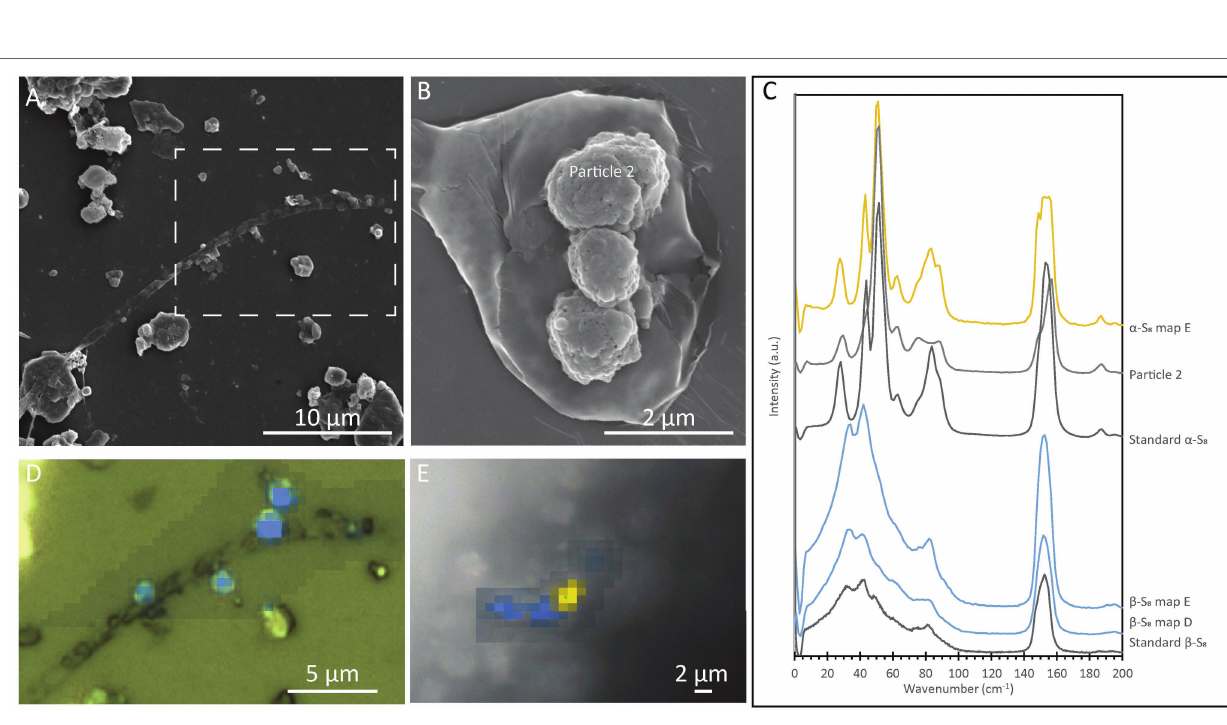
FIGURE 5 | Correlative SEM and Raman analyses of a filamentous cell with extracellular S(0) in the Sulfurovum -dominated streamer biofilm (sample PC1718). The sample was air-dried in images (A), (B) , and (D) , while Raman analyses (E) were performed while the sample was wet. (A) SEM image with a white dashed box indicating the location of the Raman map in (D) ; (B) SEM image of particles in sample PC1718. “ α -S 8 particle 2” indicates where the α -S 8 Raman spectrum (labeled “Particle 2”) in (C) was collected. (C) Ultra-low-frequency Raman spectra. Standard spectra for α -S 8 and β -S 8 are labeled accordingly. (D) Light microscopy image with an overlay Raman map. The blue areas are rich in β -S 8 . (E) Light microscopy image with a Raman map overlaid. Yellow areas are rich in α -S 8 , and blue areas are rich in β -S 8 .